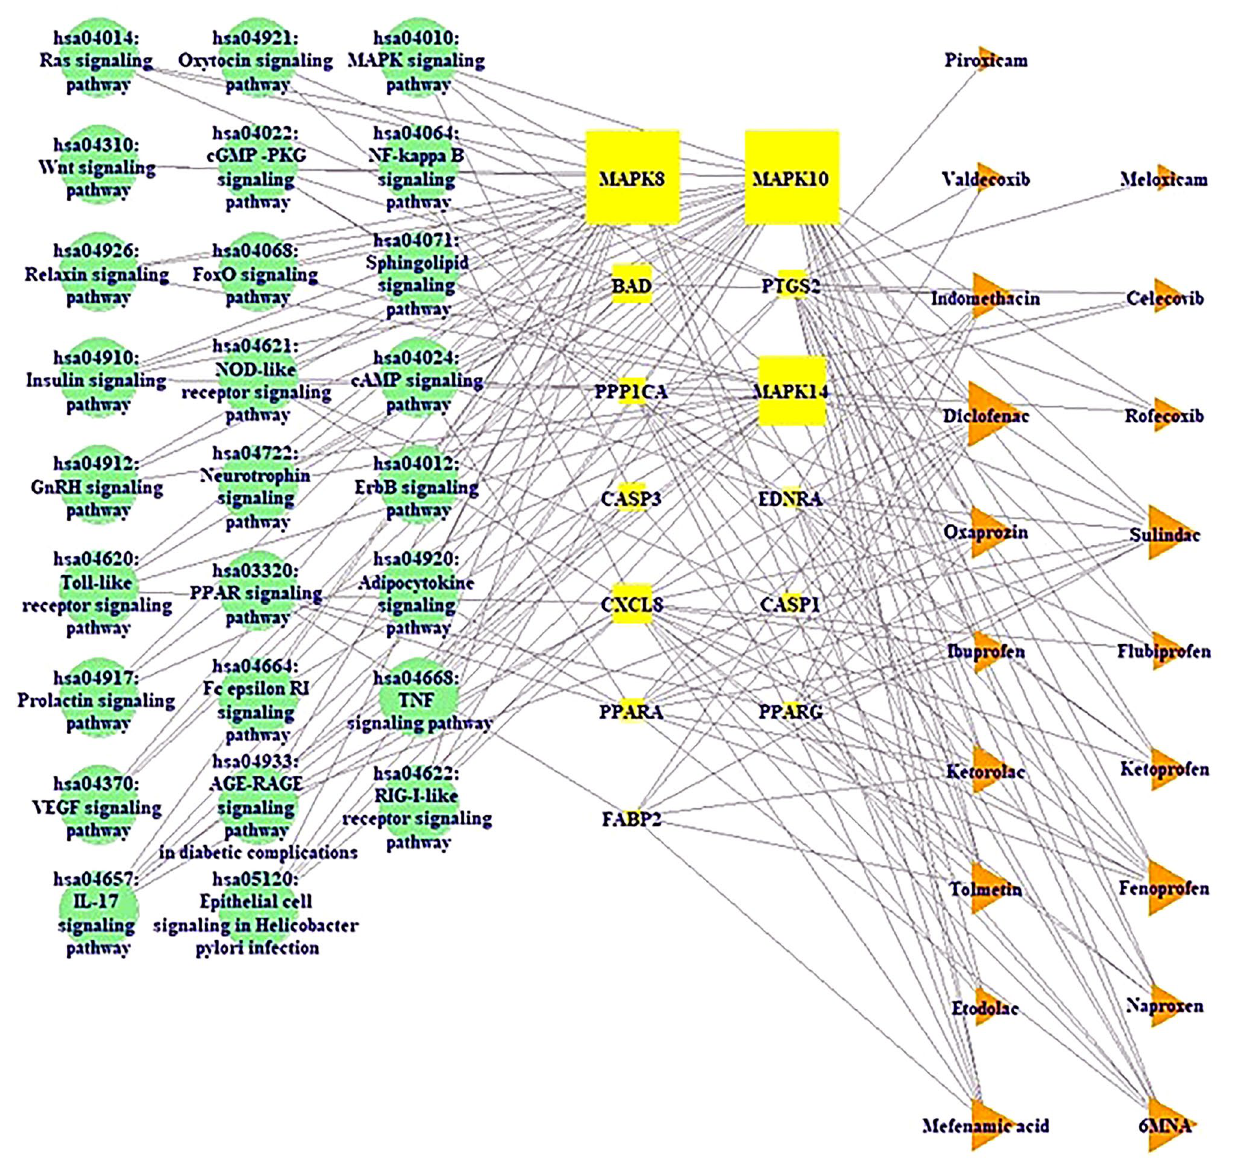
Figure 6. Signaling pathway-Target protein-NSAID (STN) networks. Green circle: signaling pathway; Yellow square: target protein; Orange triangle: